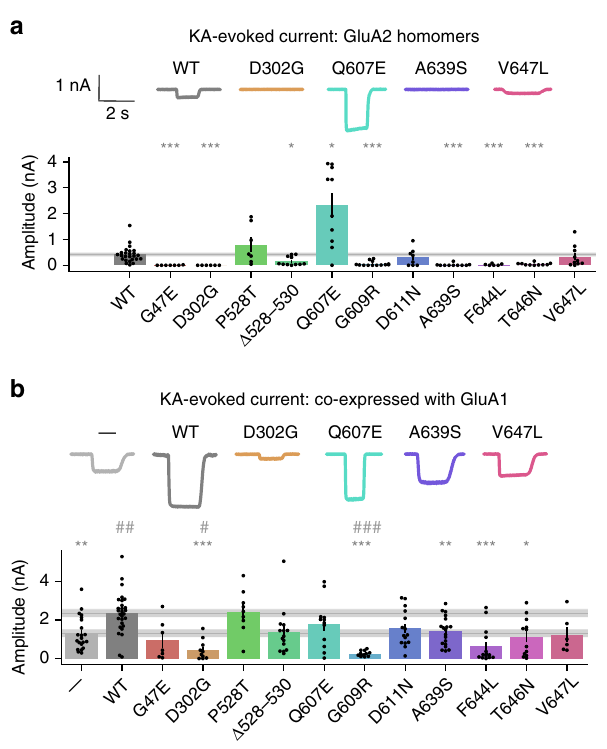
Fig. 5 Agonist-evoked currents in HEK cells. 1 mM KA was applied transiently to HEK cells expressing GluA2 and stargazin ( a ), or GluA1, GluA2 and stargazin ( b ). Amplitude was compared to WT (* p < 0.05, ** p < 0.01, *** p < 0.001) and for co-expression also to the negative control (GluA1 without GluA2, — , # p < 0.05, ## p < 0.01, ### p < 0.001). Mean ± SEM. Data are from the following numbers of independent cells: ( a )